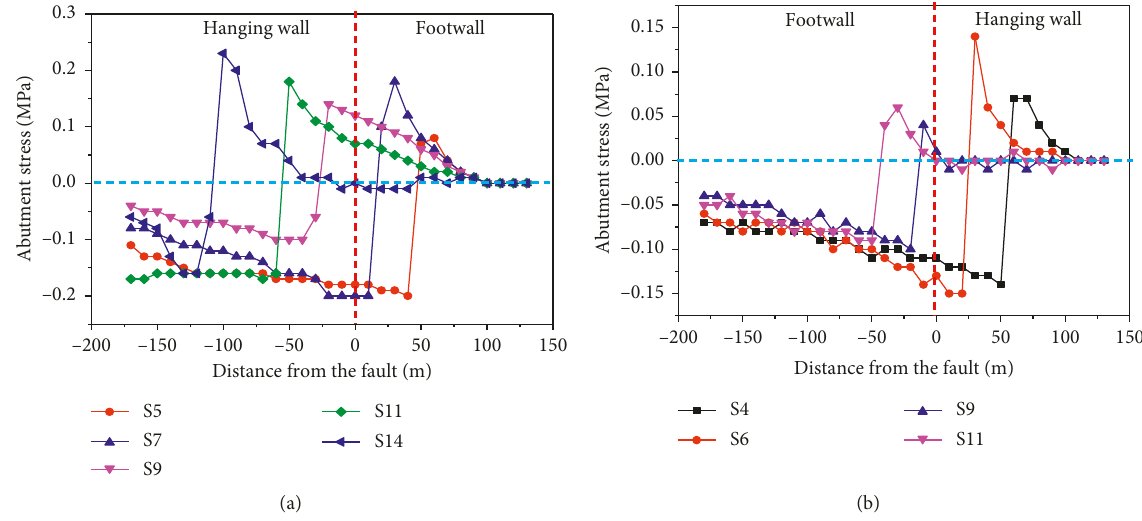
Figure 7: Variation curves of abutment stress for the coal body. (a) Footwall mining. (b) Hanging wall